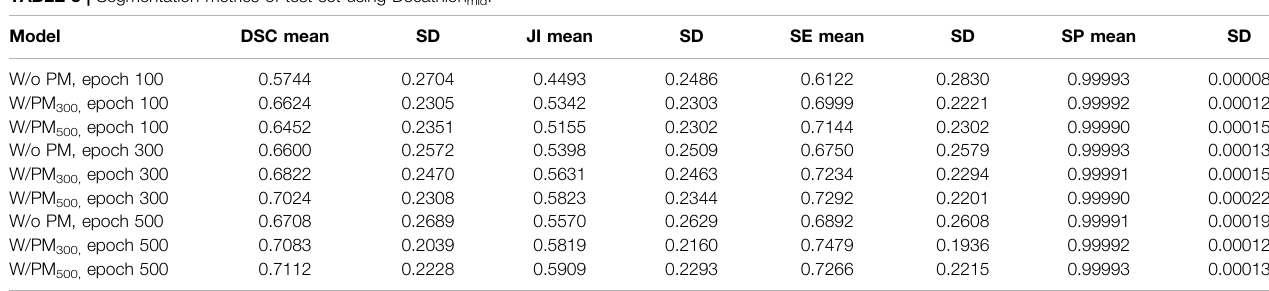
TABLE 3 | Segmentation metrics of test set using Decathlon mid